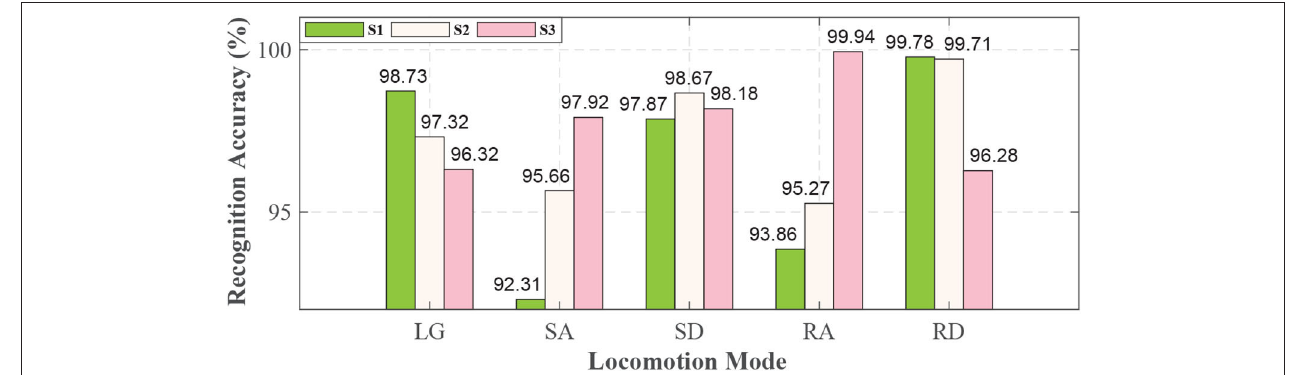
FIGURE 7 | Real-time recognition result for each locomotion mode based on QDA algorithm. The height of the bar denotes the recognition accuracy. The different colors of bars denote subjects as the legend shows.